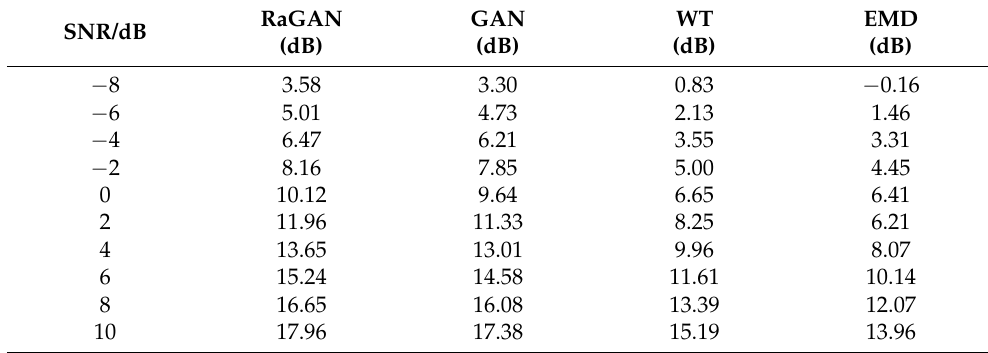
Table 5. Specific data of noise reduction performance comparison of different